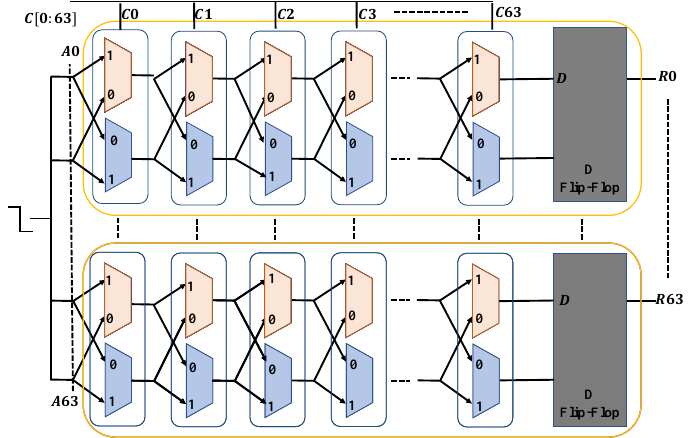
Figure 10. Arbiter